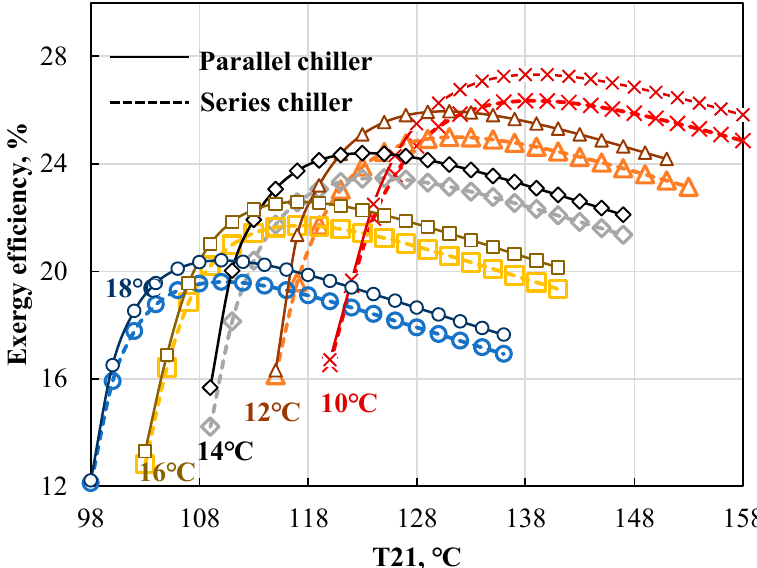
Figure 9. Variation of exergy efficiency with the two types of absorption chillers as function of chilled water temperature and steam temperature (T21).